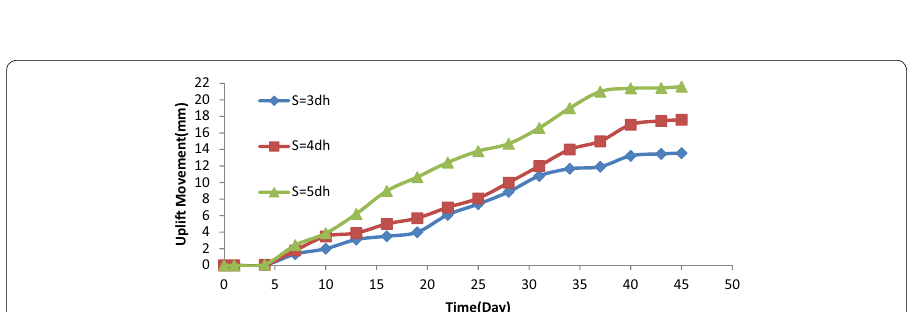
Fig. 27 Variation of uplift movement with time for pile group of L/D